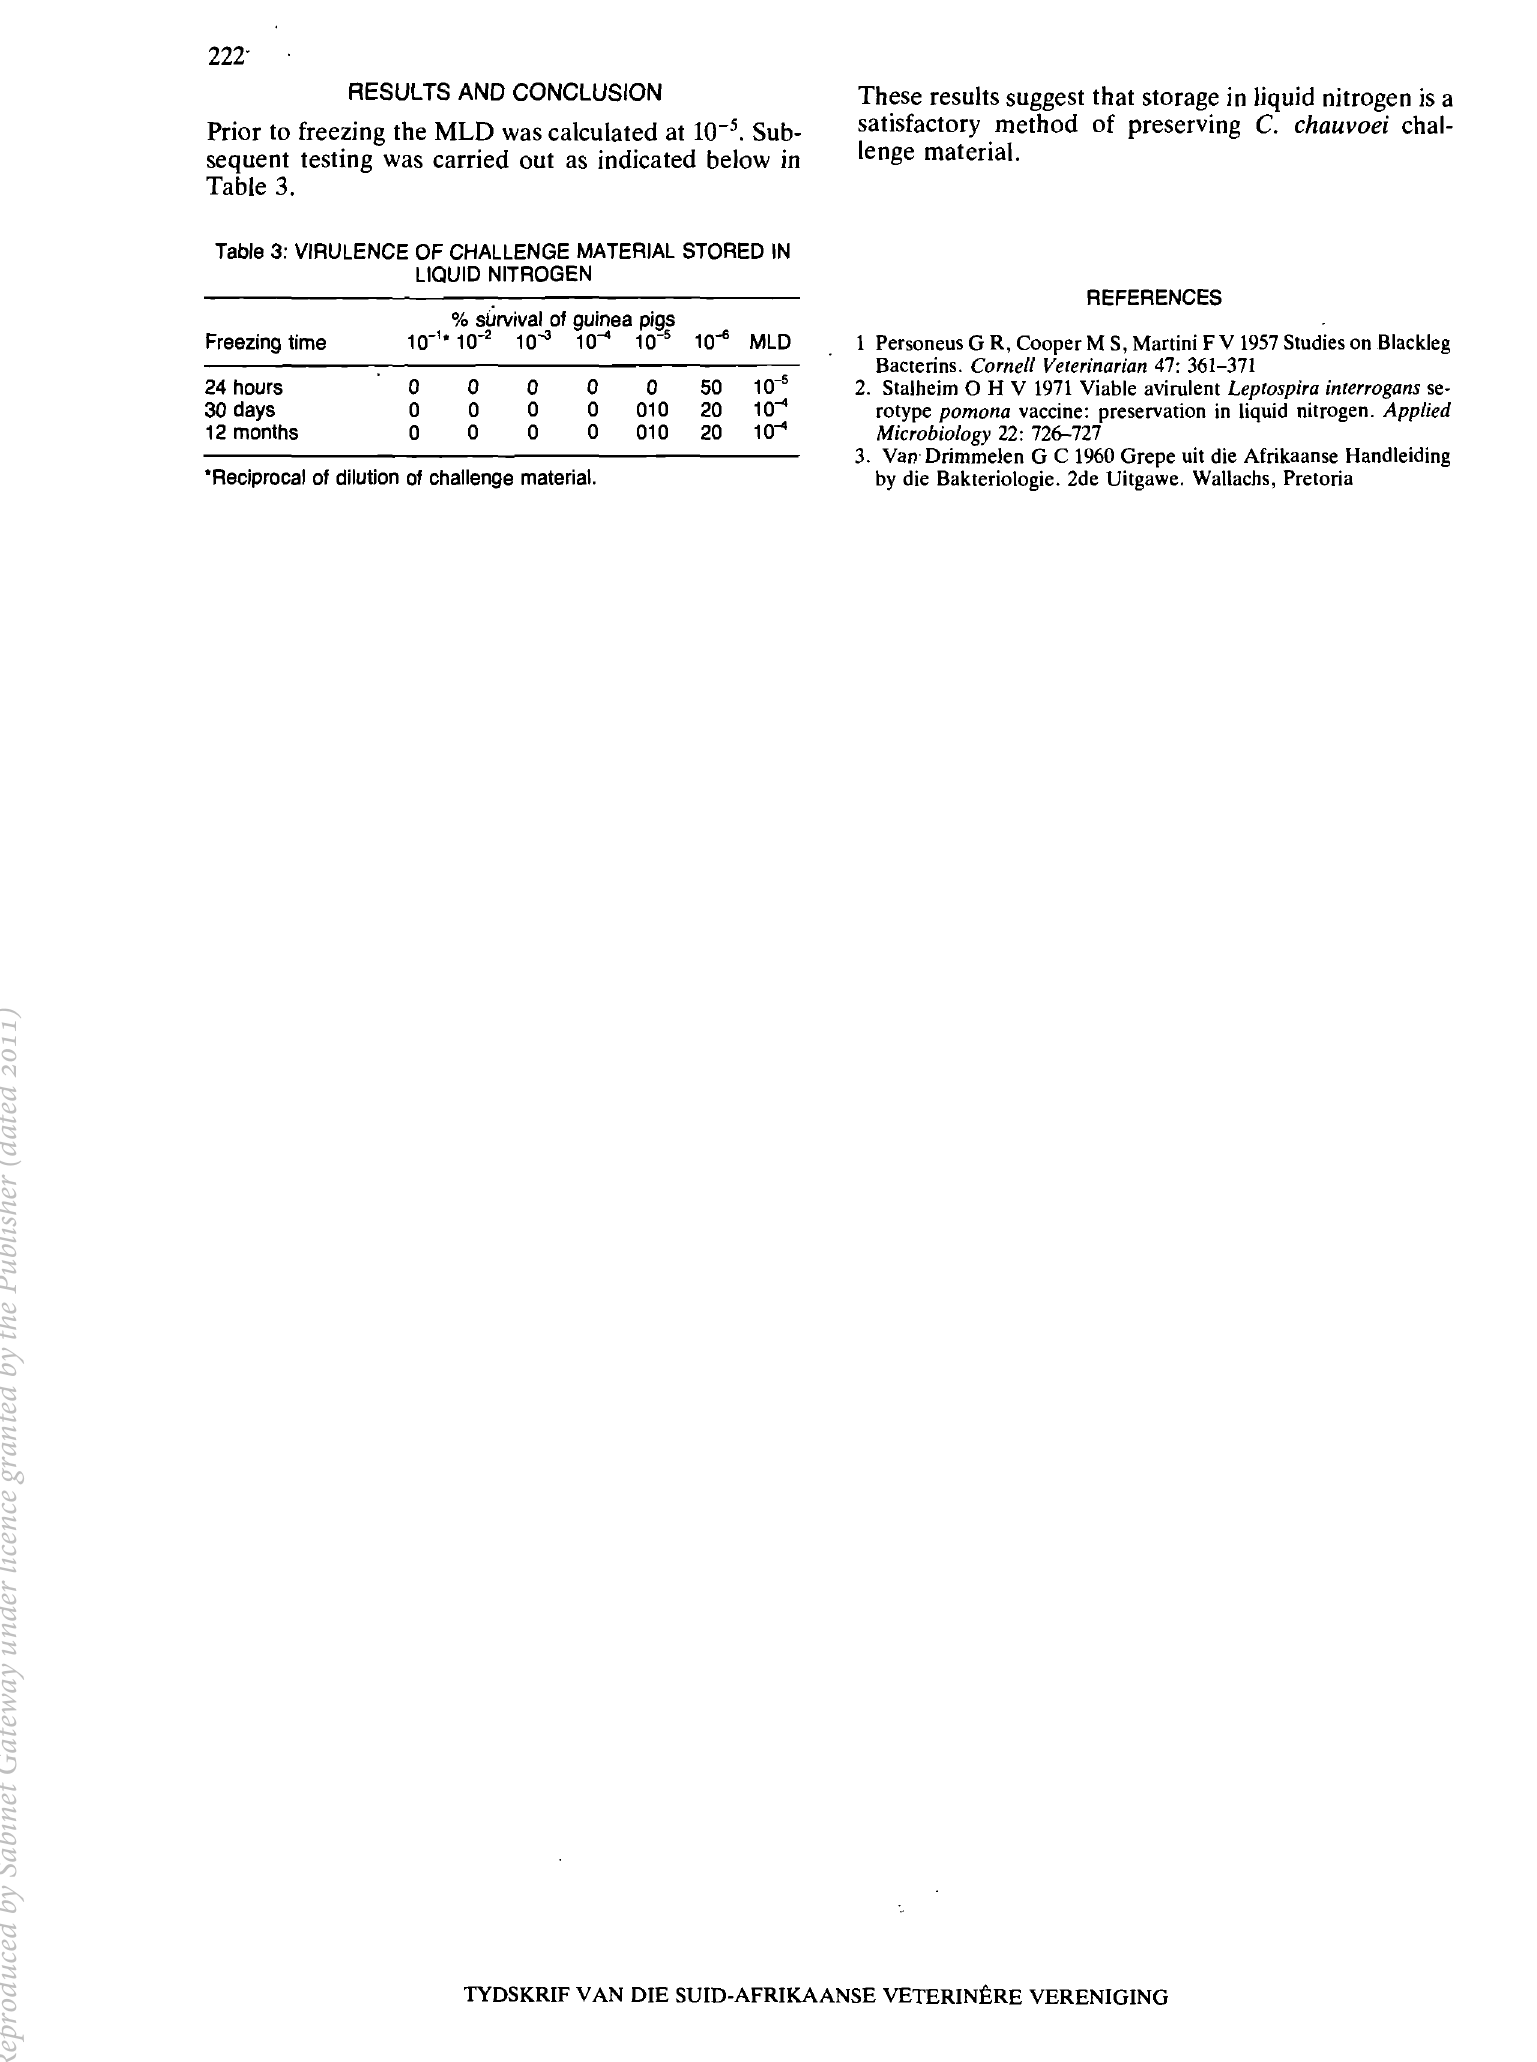
Table 3: VIRULENCE OF CHALLENGE MATERIAL STORED IN LIQUID